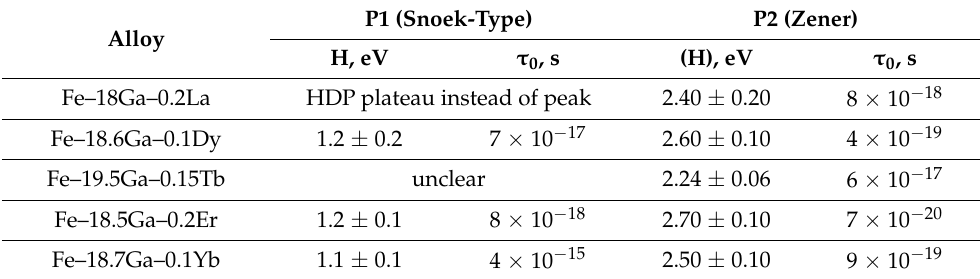
Table 2. Mean values of the activation parameters for thermally activated P1 and P2 peaks in the